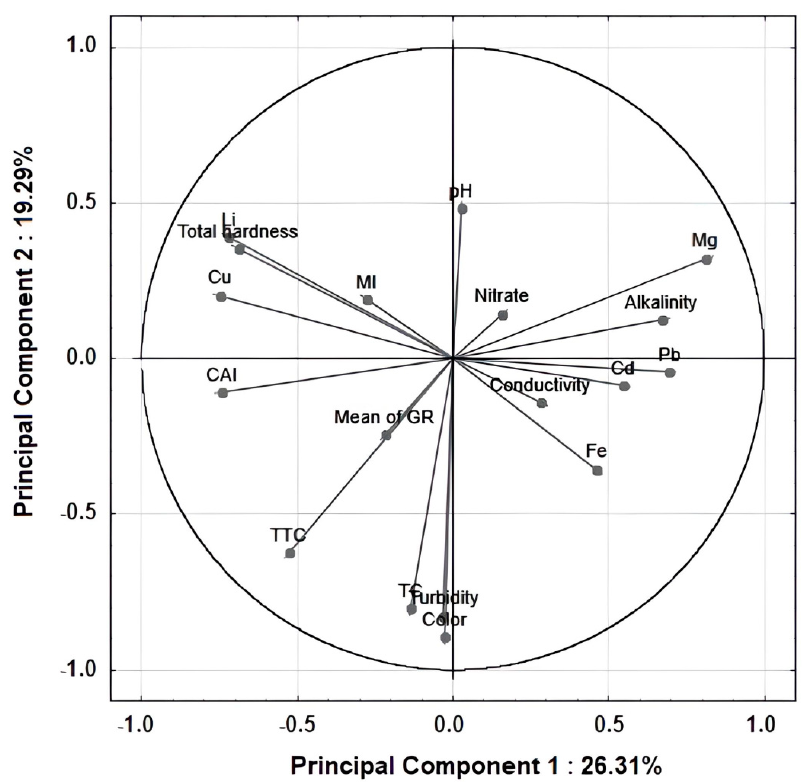
Figure 5. Principal component analysis referring to the data of physicochemical parameters, metals and quantification of total and thermotolerant coliforms of water samples from Buritis Lake. Groups that have an influence on the components have associations with each other, which are confirmed by the Pearson correlation data presented in Table 6. The strongest correlation found is between turbidity and color, with a positive correlation of 0.92, which can also be seen in Figure 5; both have close factor loads. Similarly, TC has a positive correlation with color (0.55) and turbidity (0.43). Other strong positive correlations are between Pb and Cd (0.78), Li and Cu (0.86) and nitrate and conductivity (0.77). The most accentuated negative correlations are with pH and nitrate ( − 0.70) and pH and TC (0.72). The correlation exists between metals in the same hydrologic body because it is caused by the interaction that these metals can have with other metals [34]; this may be one of the explanations for the correlations